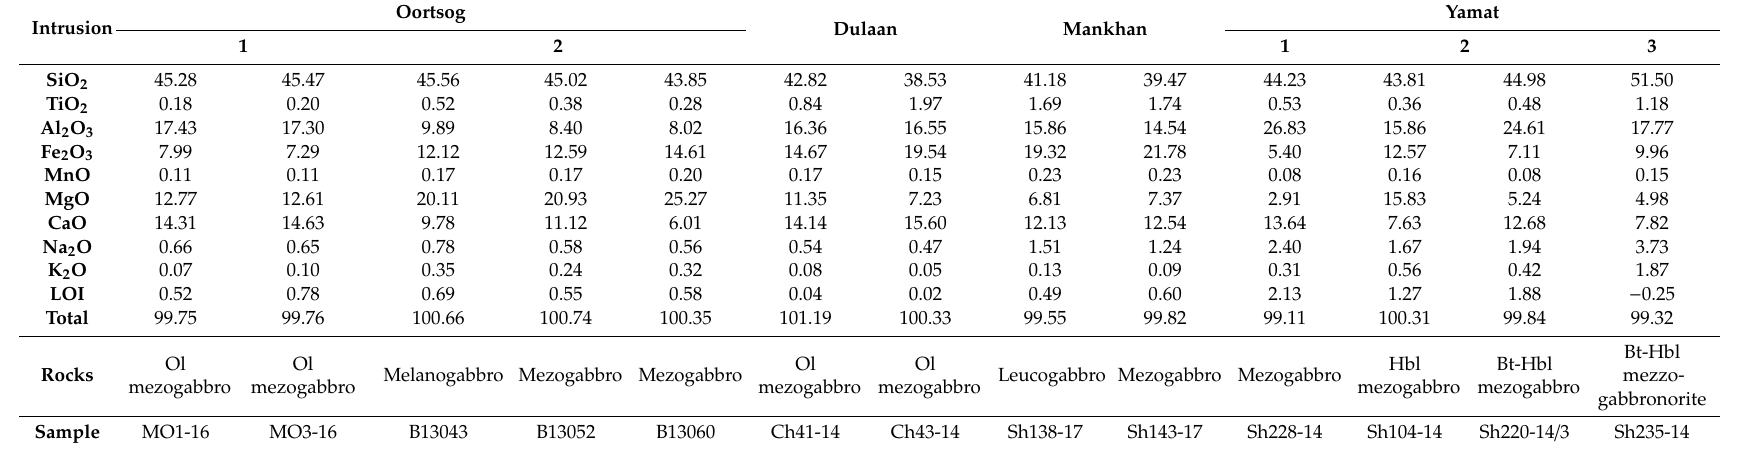
Table 1. Rock compositions (wt%) in mafic-ultramafic massifs of the Khangai